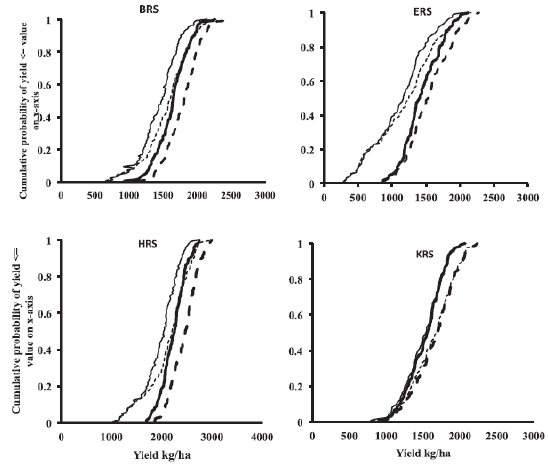
Figure 8. Cumulative probability of simulated yield distributions for the mungbean cultivar ‘Crystal’ at different row and starting moistures across four sites. Planting at 50% total plant-available water holding capacity (PAWC) in wide rows (1 m) is shown with thin continuous lines, and narrow rows (0.5 m) with thin dash lines, or at 100% PAWC with wide (thick continuous lines) and narrow rows (thick dash lines). The four sites are Biloela (BRS), Emerald (ERS), Hermitage (HRS), and Kingaroy (KRS). Yields were simulated for rain-fed crop using site-specific soil properties and historical climate data over 123 years [24] .